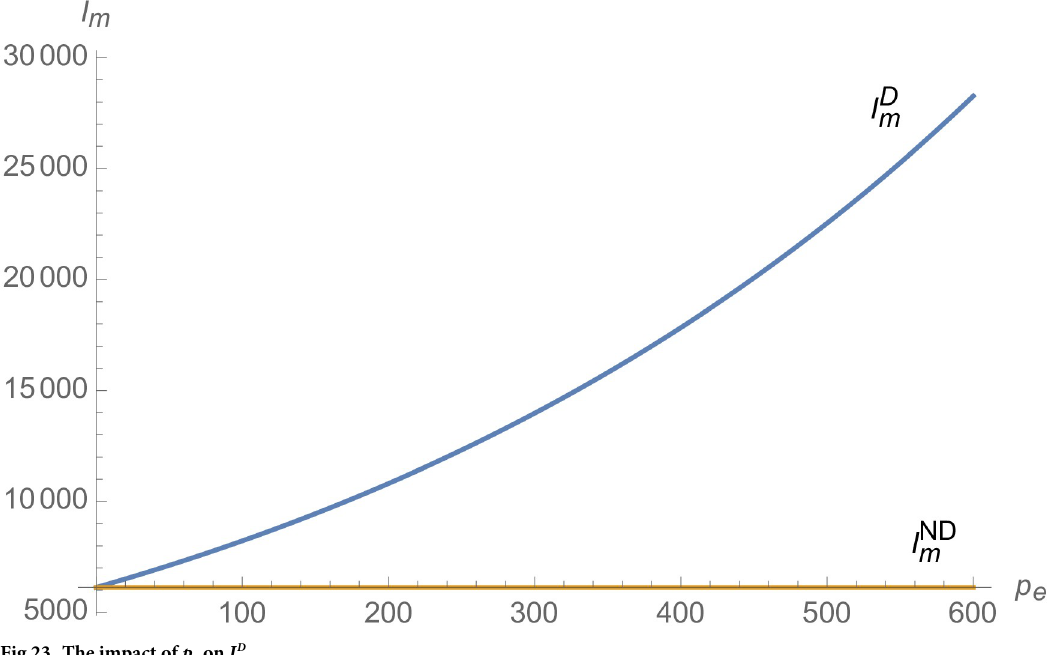
Fig 23. The impact of p e on I D